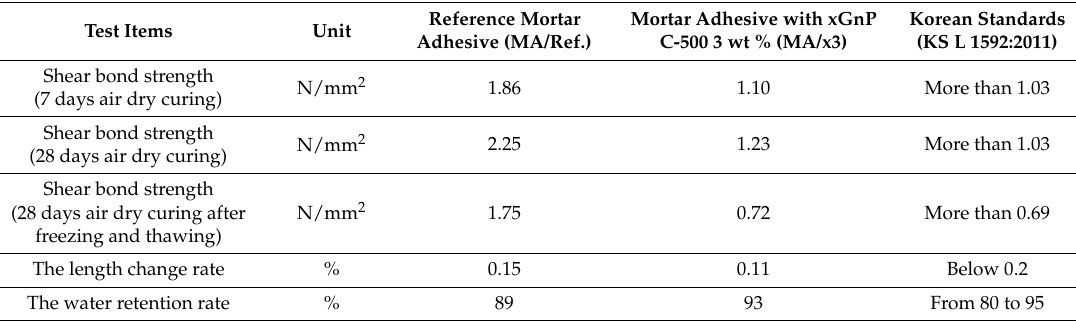
Table 4. Test results of mortar